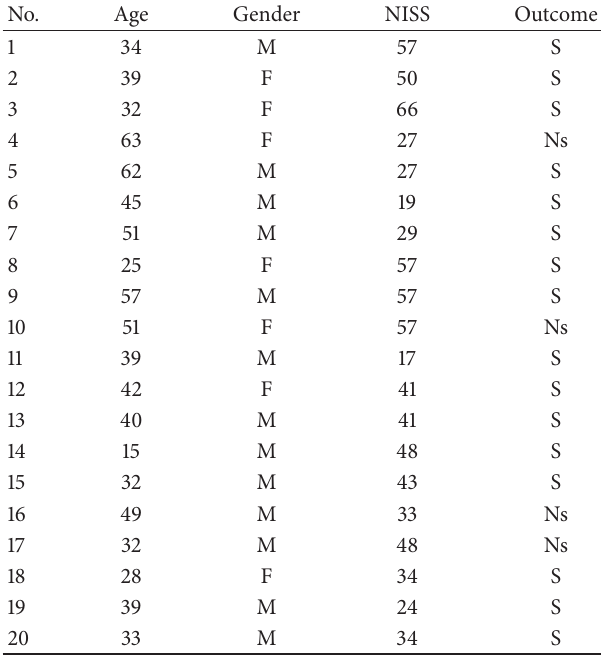
Table 1: Clinical data of all patients ( 𝑛 = 20